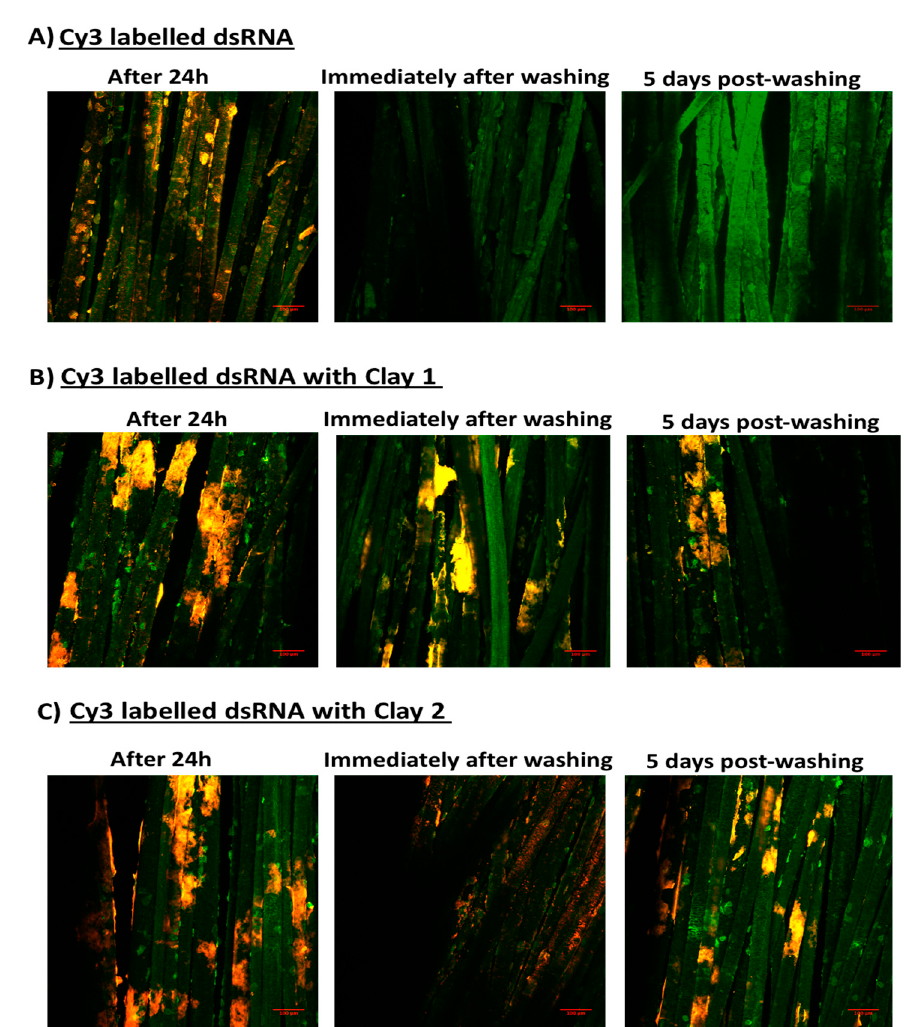
Figure 1. Confocal image of cattle skin treated with Cy3-dsRNA/Cy3-dsRNA loaded on Clay1 or Clay2. Samples imaged 24 h after application of treatment; immediately after washing and 5 days post-washing. ( A ) Cy3 labelled dsRNA; ( B ) Cy3 labelled dsRNA with Clay1; and ( C ) Cy3 labelled dsRNA with Clay2. The confocal microscopy was performed at the Australian Cancer Research Foundation (ACRF)/Institute for Molecular Bioscience Cancer Biology Imaging Facility, which was established with the support of the